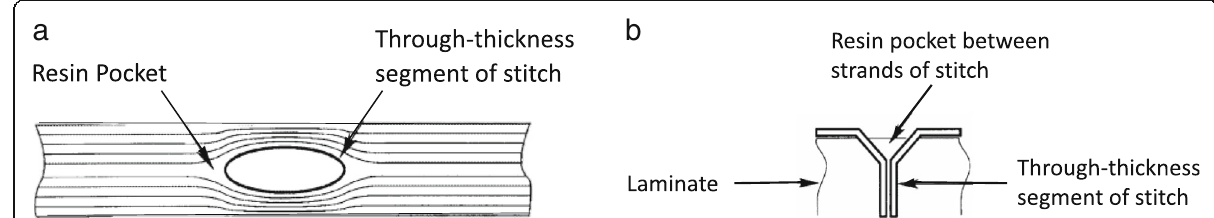
Fig. 16 Schematic of stitching defects [20] a ) in-plane fibres misalignment, b resin pocket created on the laminate surface between the stitched